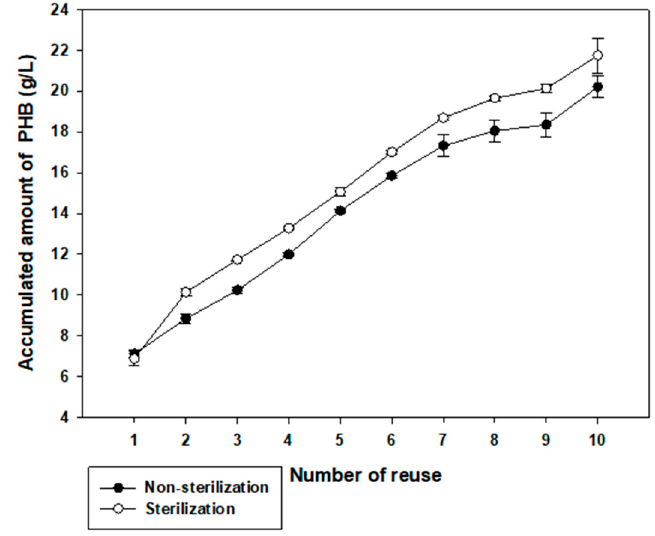
Figure 5. Effect of reused sterilized and non-sterilized high salinity medium on total PHB production. Total PHB production in non-sterilized high salinity medium with 2% galactose was compared to production in sterilized high salinity medium with 2% galactose.